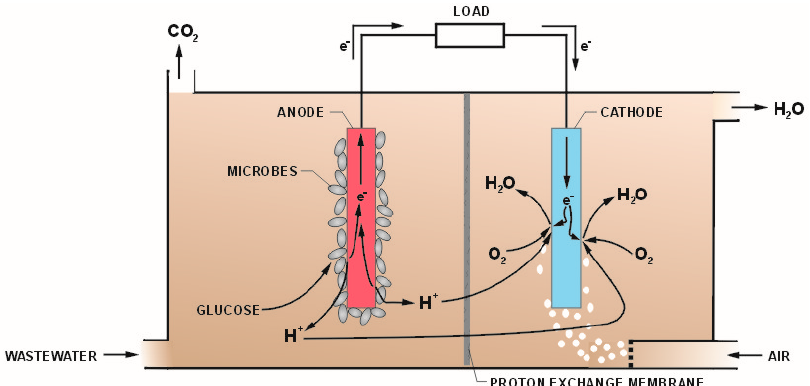
Figure 1. Operating principles of a microbial fuel cell (MFC). Figure is not to scale.